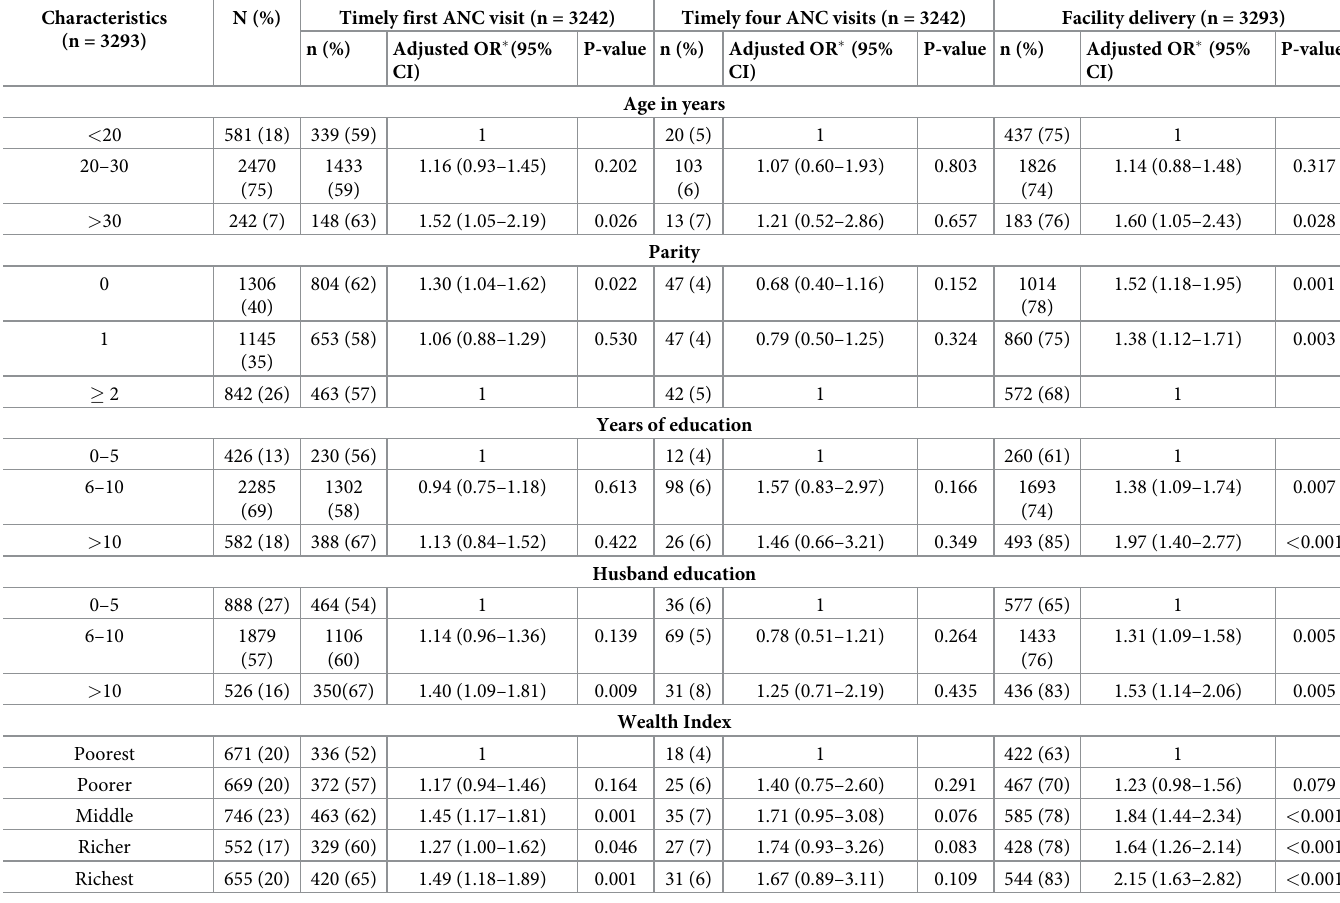
Table 2. Associations of timely first ANC visit, timely four ANC visits, and facility delivery with socio-demographic determinants: Adjusted odds ratios from logis- tic regression analysis. Characteristics (n =